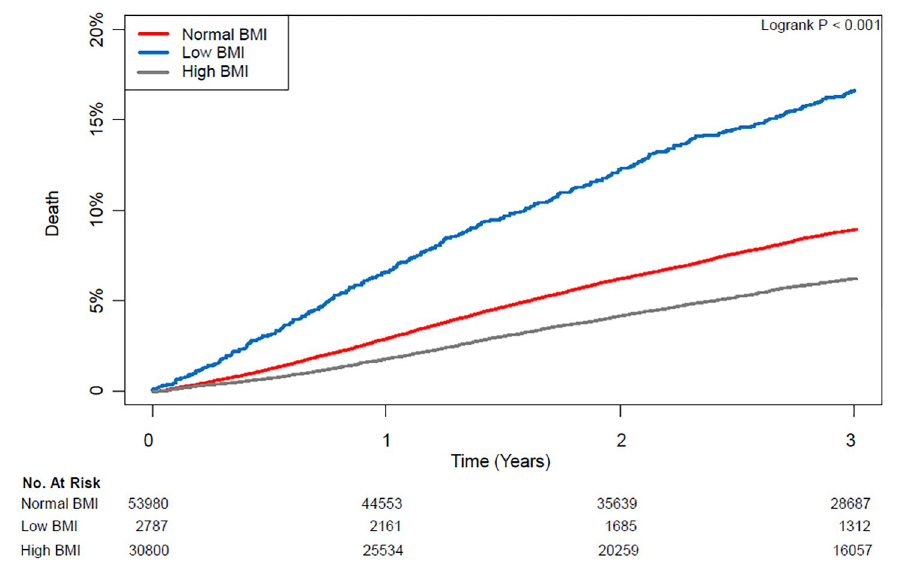
Fig 1. Kaplan–Meier curves of mortality according to body mass index during three years after cancer surgery.